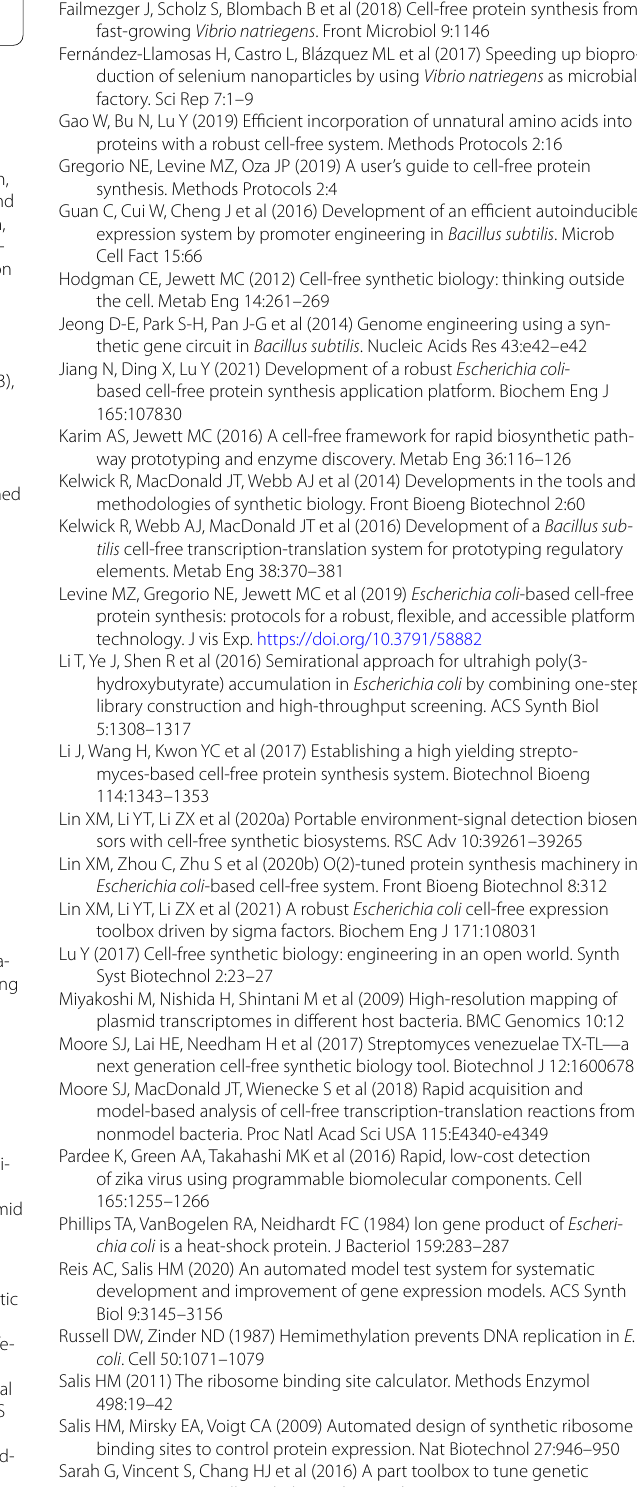
Table S4. Optimum conditions in the V. natriegens , C. glutamicum , B. subti- lis and E. coli CFPS expression systems. Table S5. The significance analysis of different reagent components in four CFPS